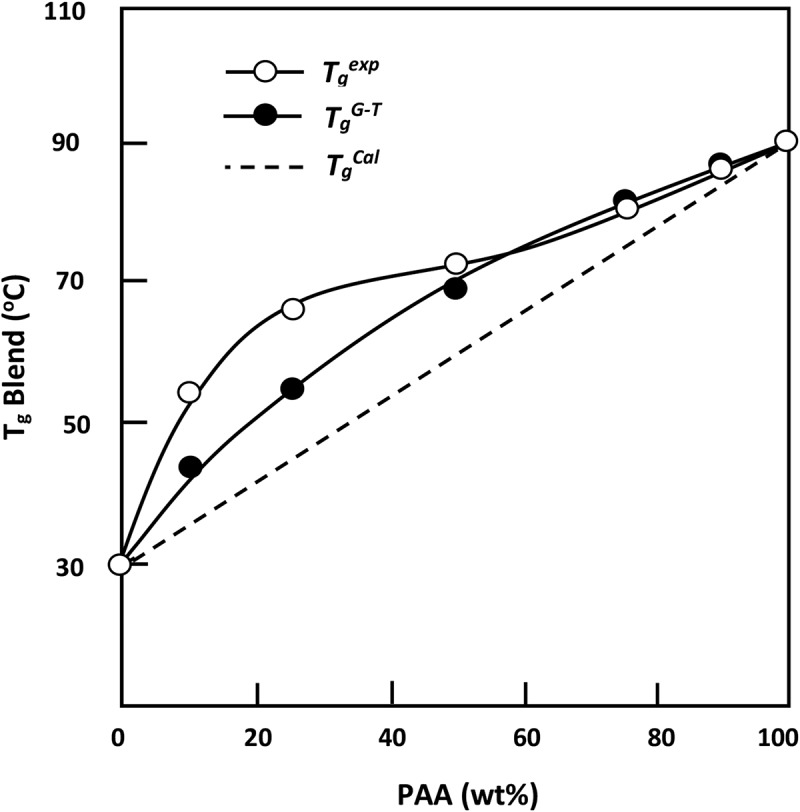
Variations of the Tgexp, TgCal, TgFox and TgG-T of PAA/PMVK blend versus the composition.